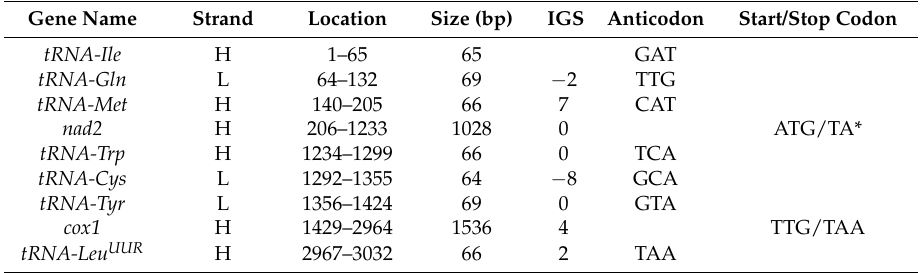
Table 2. Annotation of the complete mitogenome of Cryptocercus meridianus